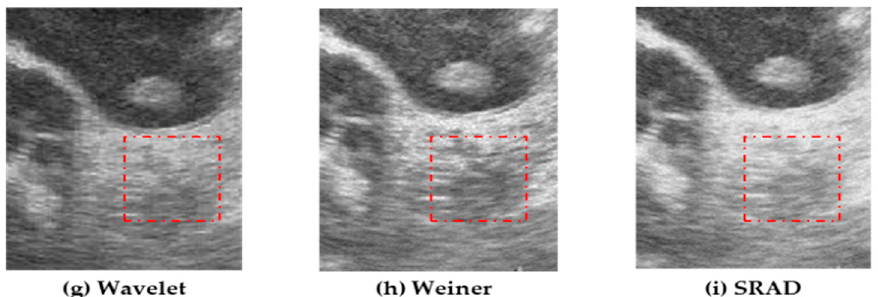
Figure 10. ( a ) Zoomed sub-image of noisy thrombus ultrasound images. The red boxes highlight texture details of images for visual assessment. Results of proposed method using ( b ) Dictionary 1 and ( c ) Dictionary 2. Results using the ( d ) Frost; ( e ) median; ( f ) Kuan; ( g ) wavelet; ( h ) Weiner; and ( i ) SRAD filters.